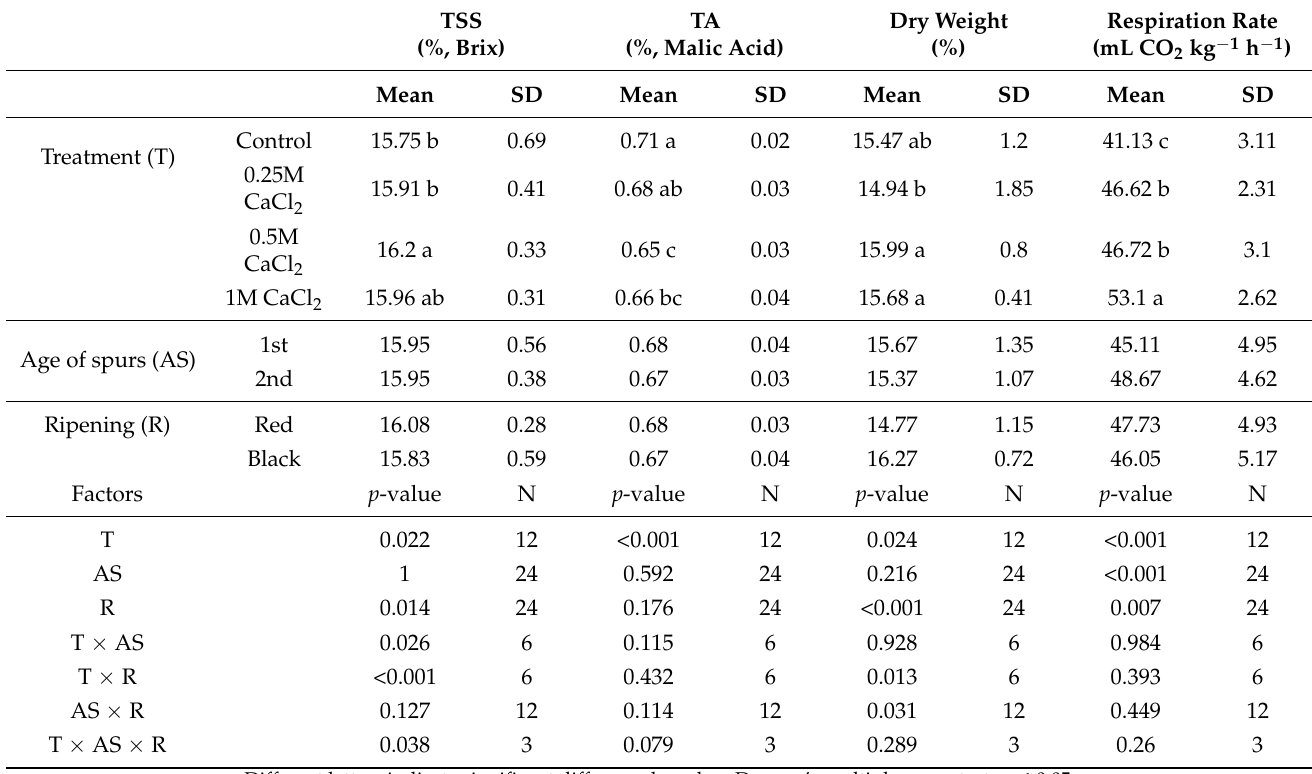
Table 3. The effect of calcium treatments (0, 0.25, 0.5, and 1M CaCl 2 *2H 2 O), ages of short spurs (1- and 2-year-old spurs), and the ripening stage (red and black colour fruits) in the TSS, TA, dry weight, and the respiration rate of the